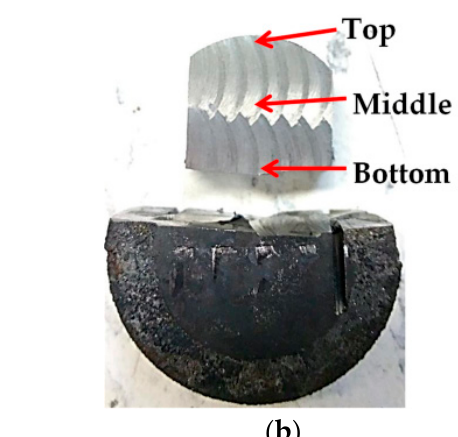
Figure 2. Lobe taken from camshaft showing ( a ) the sample heat treated and ( b ) the three regions analyzed from top to bottom.